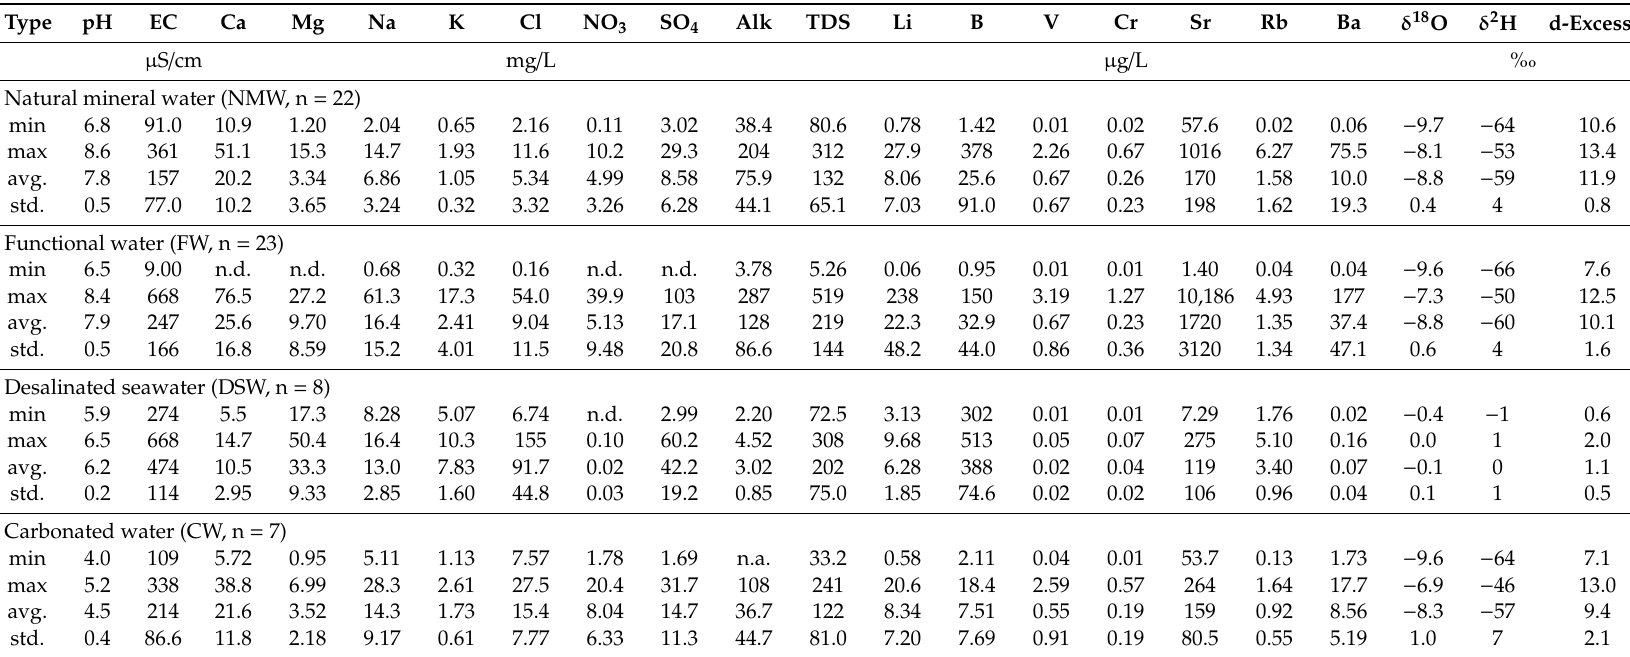
Table 1. Statistics for major and trace element contents and water isotopes in four types of Korean bottled water. pH and EC measured in laboratory are listed as well. Type